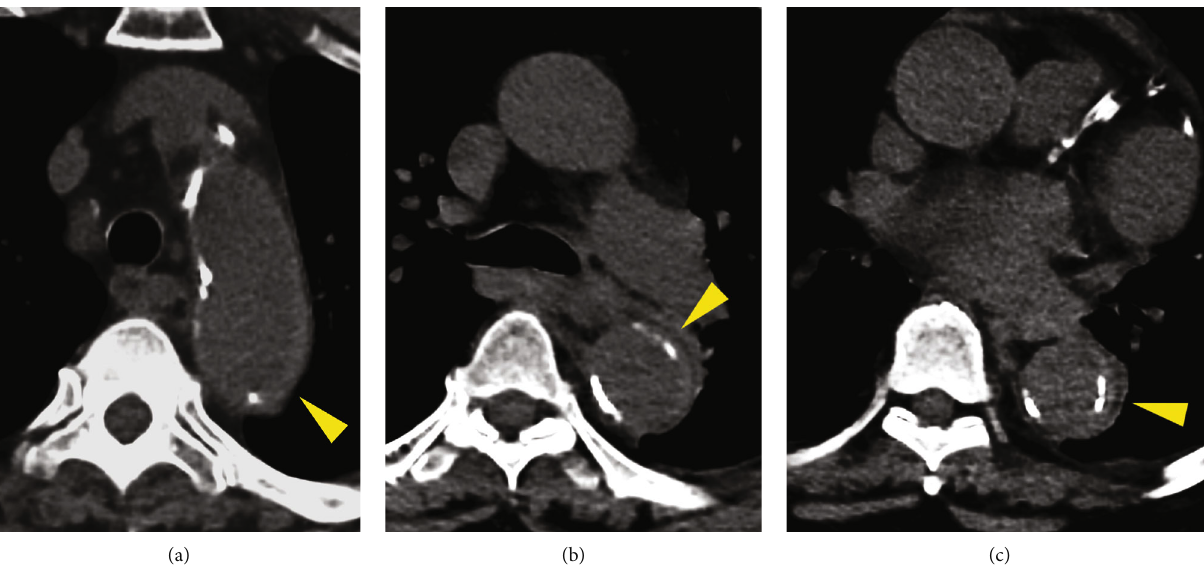
Figure 2: Unenhanced axial CT images of proximal thoracic aorta, showing a very thin aortic intramural hematoma below intimal calci fi cations (yellow arrowheads in (a –